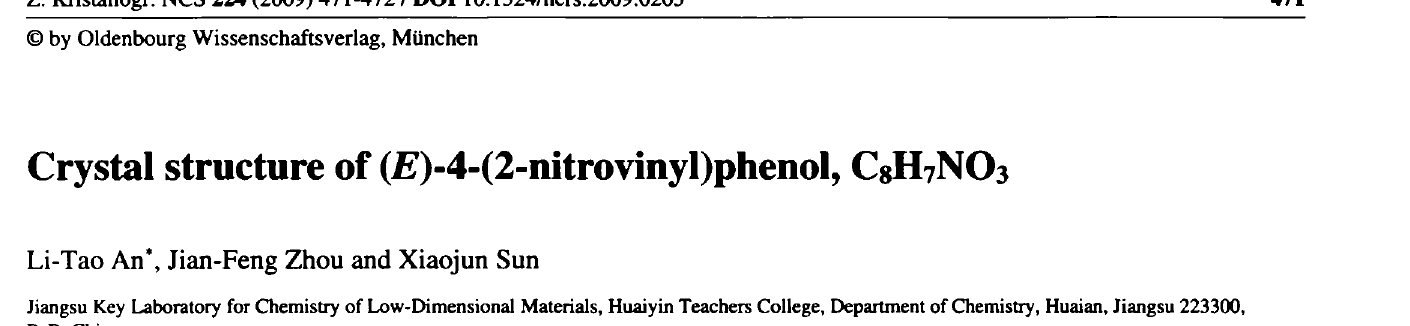
Table 1. Data collection and handling.